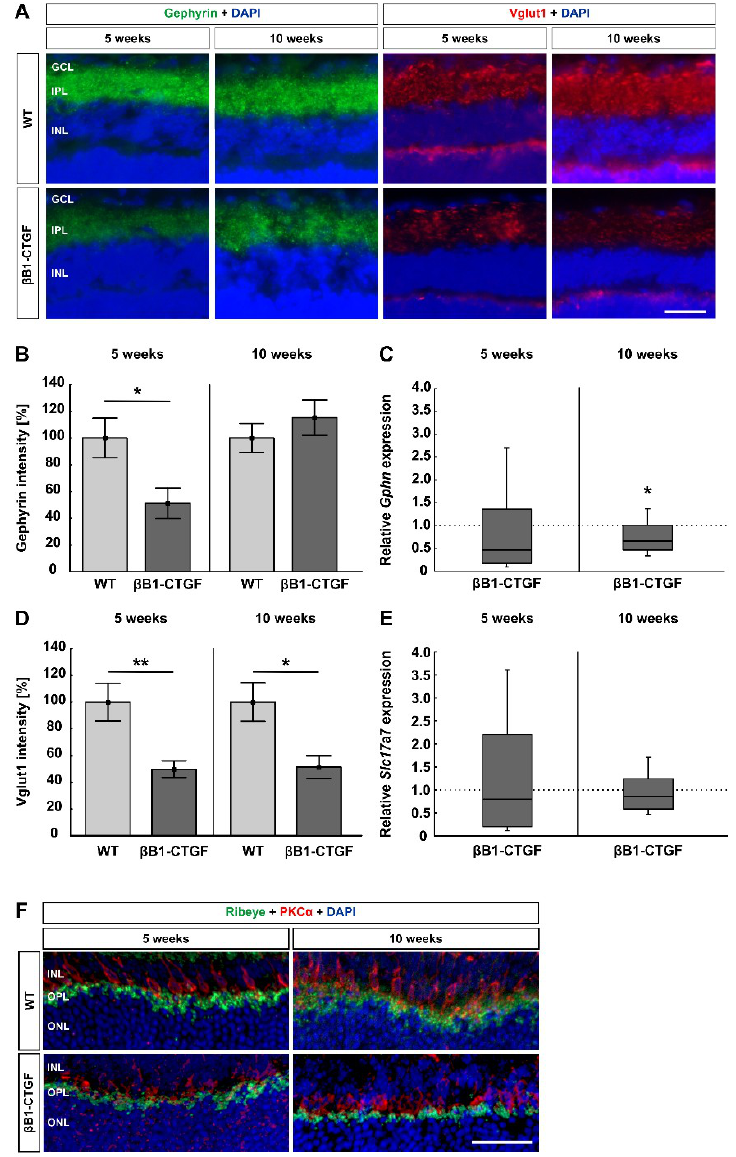
Figure 3. Loss of synapses. ( A ) GABAergic synapses were labeled using gephyrin (green) and glutamatergic synapses were stained with Vglut1 (red), while cell nuclei were counterstained with DAPI (blue) at 5 and 10 weeks of age (n = 7–8/group). ( B ) At 5 weeks of age, a significantly decreased gephyrin + intensity was revealed in β B1-CTGF mice ( p = 0.02). At 10 weeks, the staining intensity reverted to the WT level. ( C ) The mRNA expression levels of Gphn (n = 5–7/group) showed no changes at 5 weeks, but a significant downregulation was shown in 10-week-old β B1-CTGF mice ( p = 0.02). ( D ) Regarding Vglut1 staining, significantly decreased immunoreactivity was noted in transgenic mice at 5 ( p = 0.007) and 10 weeks of age ( p = 0.01). ( E ) RT-qPCR analyses detected no alterations in Slc17a7 (Vglut1) mRNA expression levels at both points in time (n = 5–7/group). ( F ) Exemplary, retinal cross sections were labeled with antibodies against ribeye (ribbon synapses; green) and PKC α (rod bipolar cells; red). DAPI counterstained cell nuclei (blue). At 5 and 10 weeks, β B1-CTGF and WT mice displayed distinct co-staining of both markers in the inner plexiform and outer plexiform layer. In the WT animals at both ages, the co-staining was more intense compared to transgenic mice. Abbreviations: GCL = ganglion cell layer, IPL = inner plexiform layer, INL = inner nuclear layer, OPL = outer plexiform layer, ONL = outer nuclear layer. Values are mean ± SEM for immunohistology and median ± quartile + maximum/minimum for RT-qPCR. The dotted lines in C and E represent the relative expression levels of the WT group. Scale bars: 20 µ m. * p < 0.05, ** p <